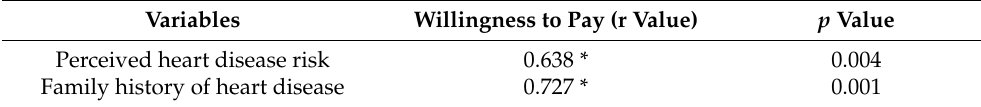
Table 6. Spearman correlation test. Variables Willingness to Pay (r Value) p Value Perceived heart disease risk Family history of heart